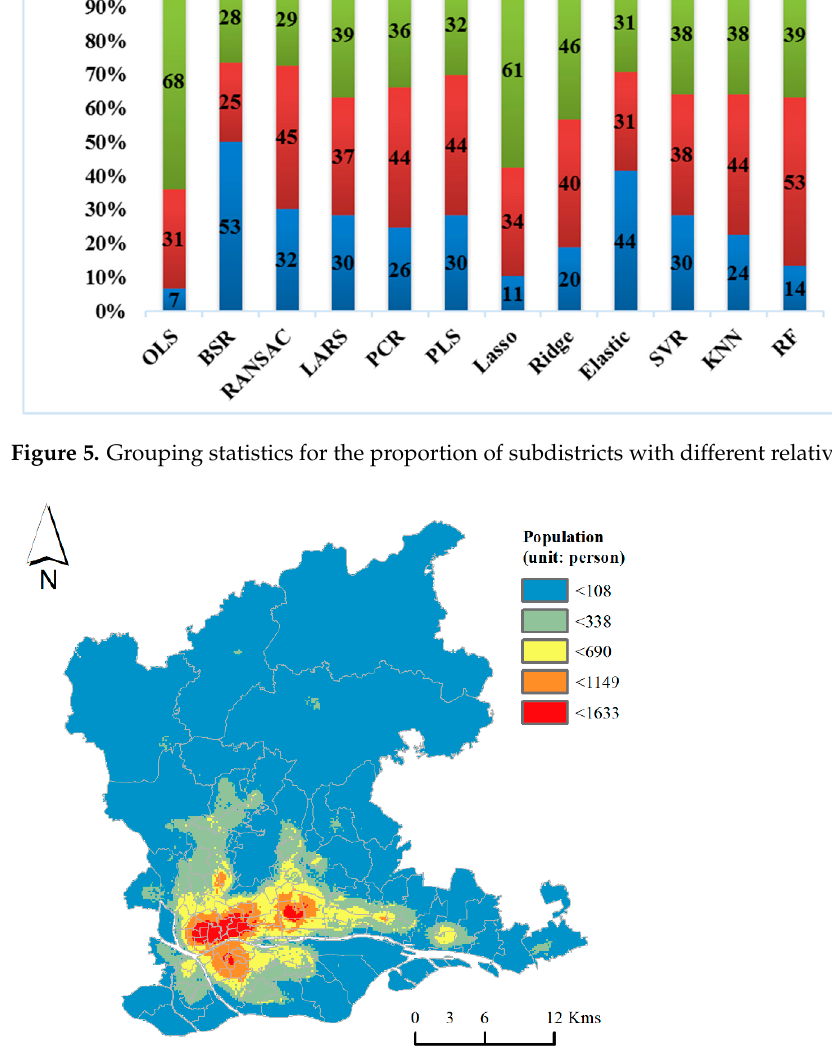
Figure 6. Gridded population map derived from the KNN model.